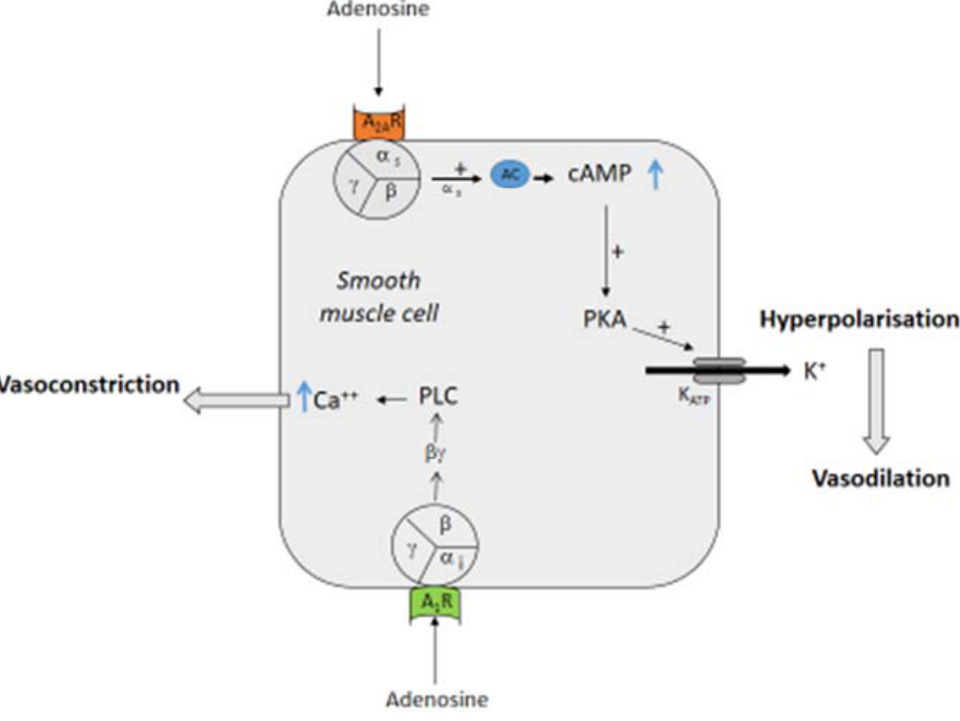
Figure 1. Effects of adenosine on smooth muscle cells. Binding of adenosine on A 2A adenosine receptor (A 2A R) leads to the activation of adenyl cyclase (AC) via the α s subunit of the G protein that increases cyclic AMP (cAMP, indirect effect), activating the protein kinase A (PKA) and then opening a K ATP channel. The efflux of K + in the extracellular space leads to muscle cell relaxation. Binding of adenosine to the adenosine A 1 receptor (A 1 R) leads to the activation of a phospholipase C (PLC) via the βγ complex of the G i protein (direct effects), inducing the release of calcium (Ca ++ ) from the reticulum in the cytosol and then the contraction of the muscle cell.